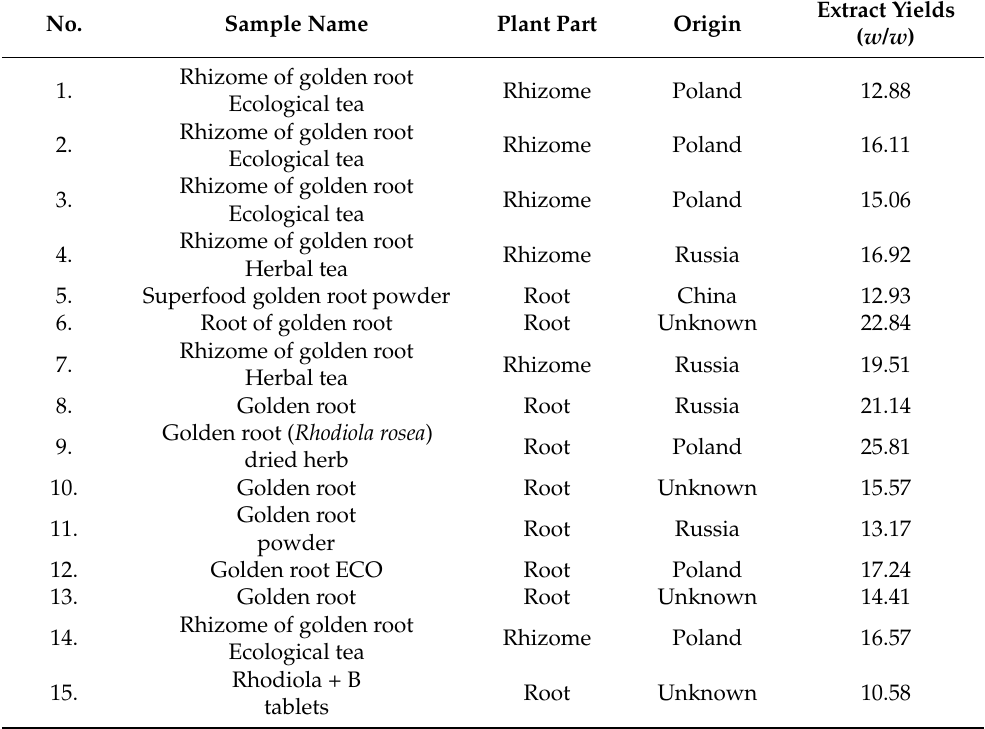
Table 1. Characteristics of Rhodiola rosea samples used in this